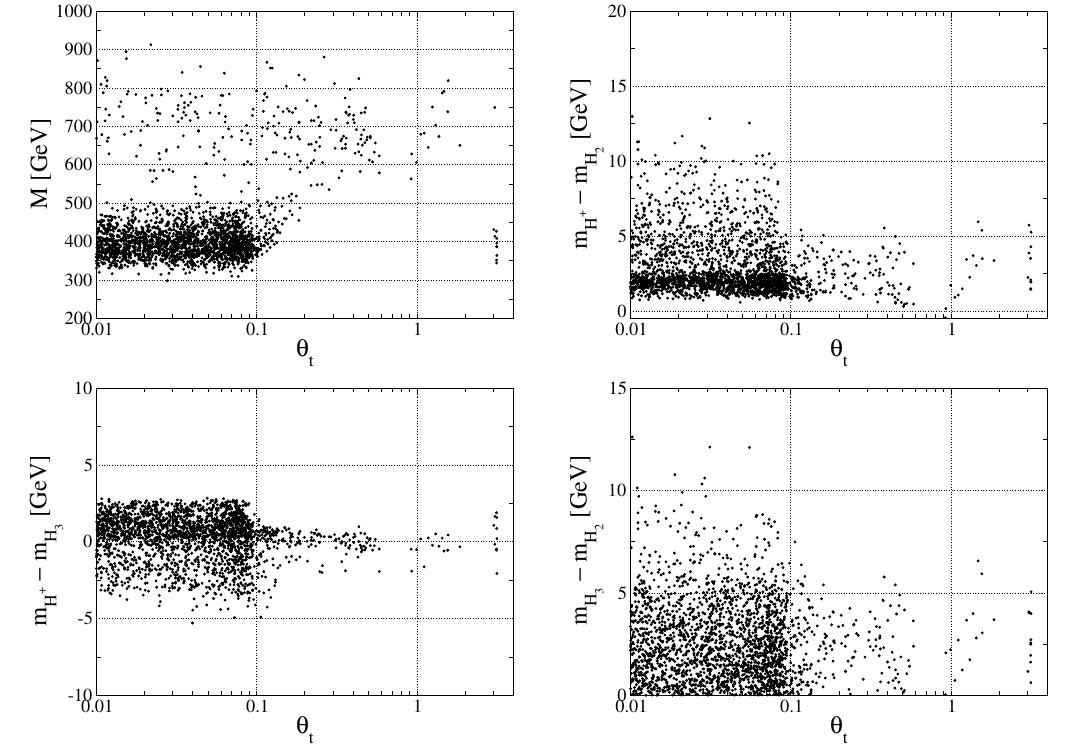
Figure 4 . Dimensionful parameter M (top-left) and the mass differences between two additional Higgs bosons as functions of θ t